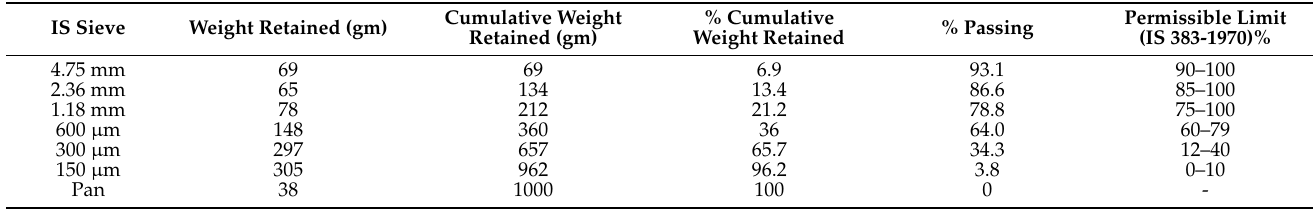
Table 2. Gradation of M sand.